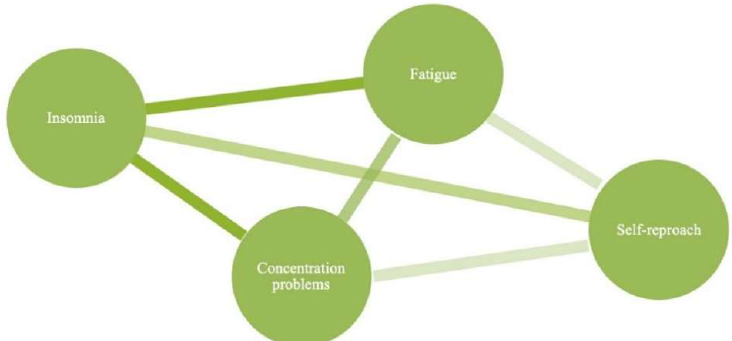
Figure 2. Symptom Network Model of Psychological Features. This figure shows a hypothetical symptom network model of the symptoms: insomnia, fatigue, concentration and self-reproach. The symptoms are connected by edges that could represent causal relationships or co-occurrence. The edges further have weights which represent the magnitude of the relationship between two symptoms, in this example, insomnia and fatigue would be highly related, but self-reproach and concentration less so. Together, the symptom network approach endeavours to view symptoms in relation to each other, which removes the need for a unified underlying cause to higher-level psychological terms.